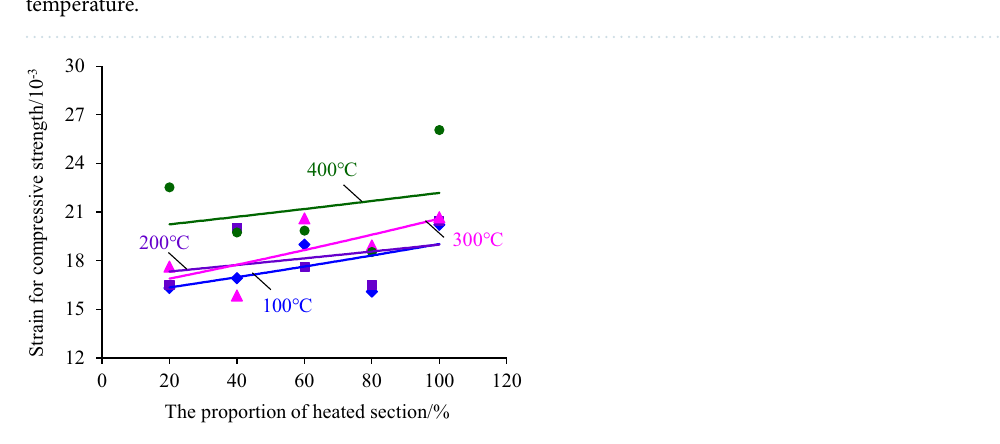
Figure 9. The changing law of the strain corresponding to the compressive strength with the increase of the heating segment